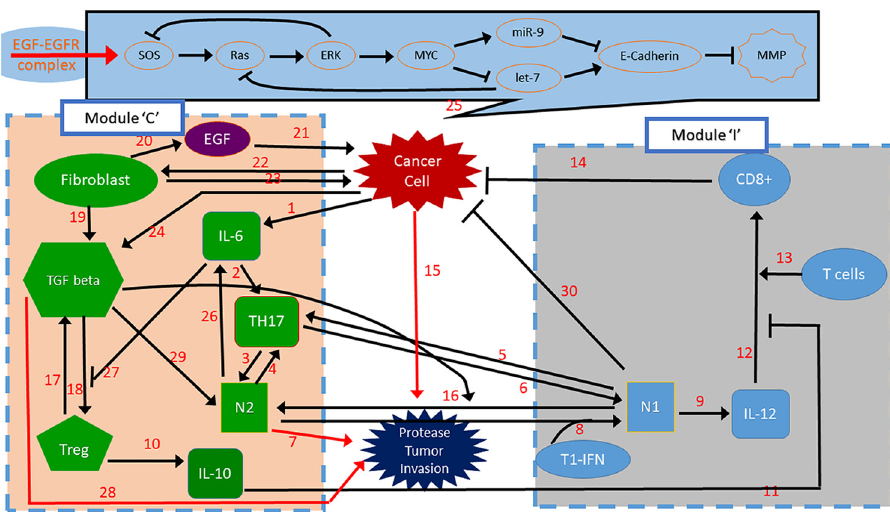
Fig 1. A schematic of tumor-microenvironment interaction. (Top) A signaling pathway for lung cancer. (Bottom) Network of interactions between cells involved (cancer cells, fibroblasts, Th17 cells, N1 cells, N2 cells, CD8+ T cells, Tregs) and cytokines and growth factors (EGF, IL-6, IL-10, IL-12, MMPs, TGF β ). By convention, the kinetic interpretation of solid arrows and hammerheads in the interaction network represents induction (arrow) and inhibition (hammerhead), respectively. The module on the left and right will be represented by a module ‘C’ and ‘I’, respectively, in our simplified mathematical model. References for each interaction (number on the arrow or hammerhead) are provided in Table